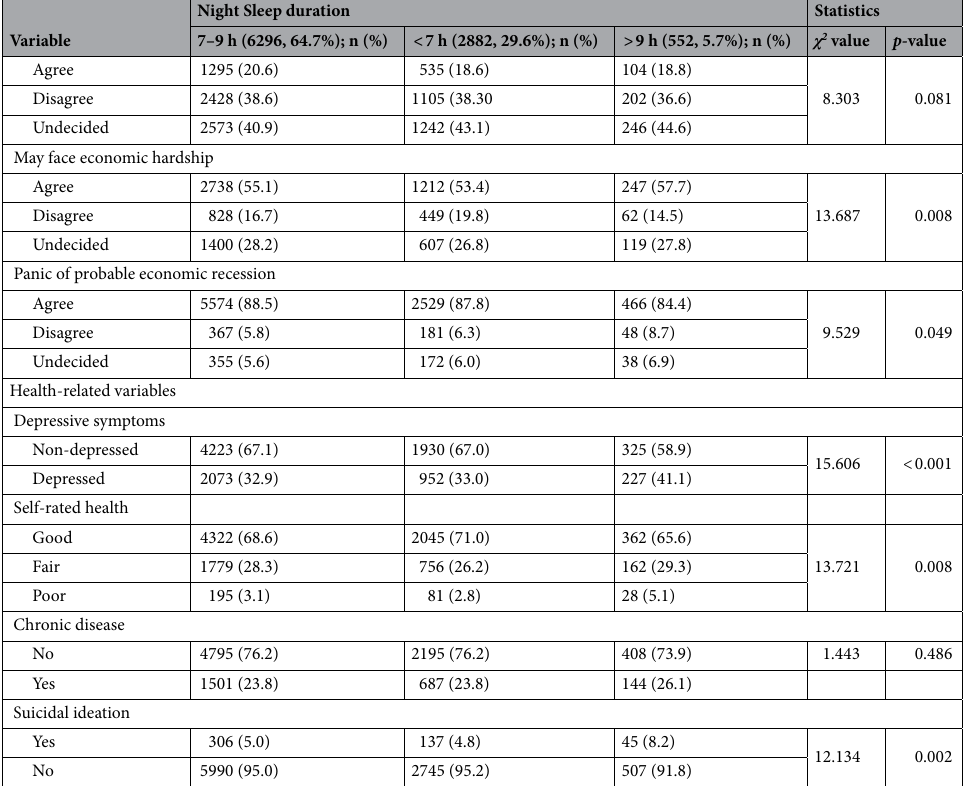
Table 3. Associations between the study variables and night sleep duration. 7–9 h, recommended sleep duration; < 7 h, shorter sleep duration than recommended; > 9 h, longer sleep duration than